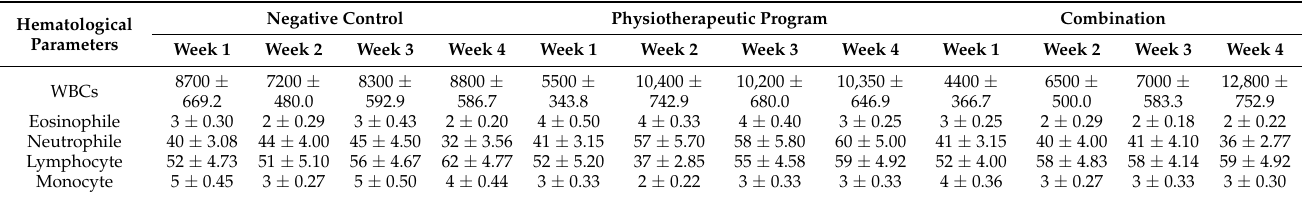
Table 1. Hematological parameters of the experimental rat groups.